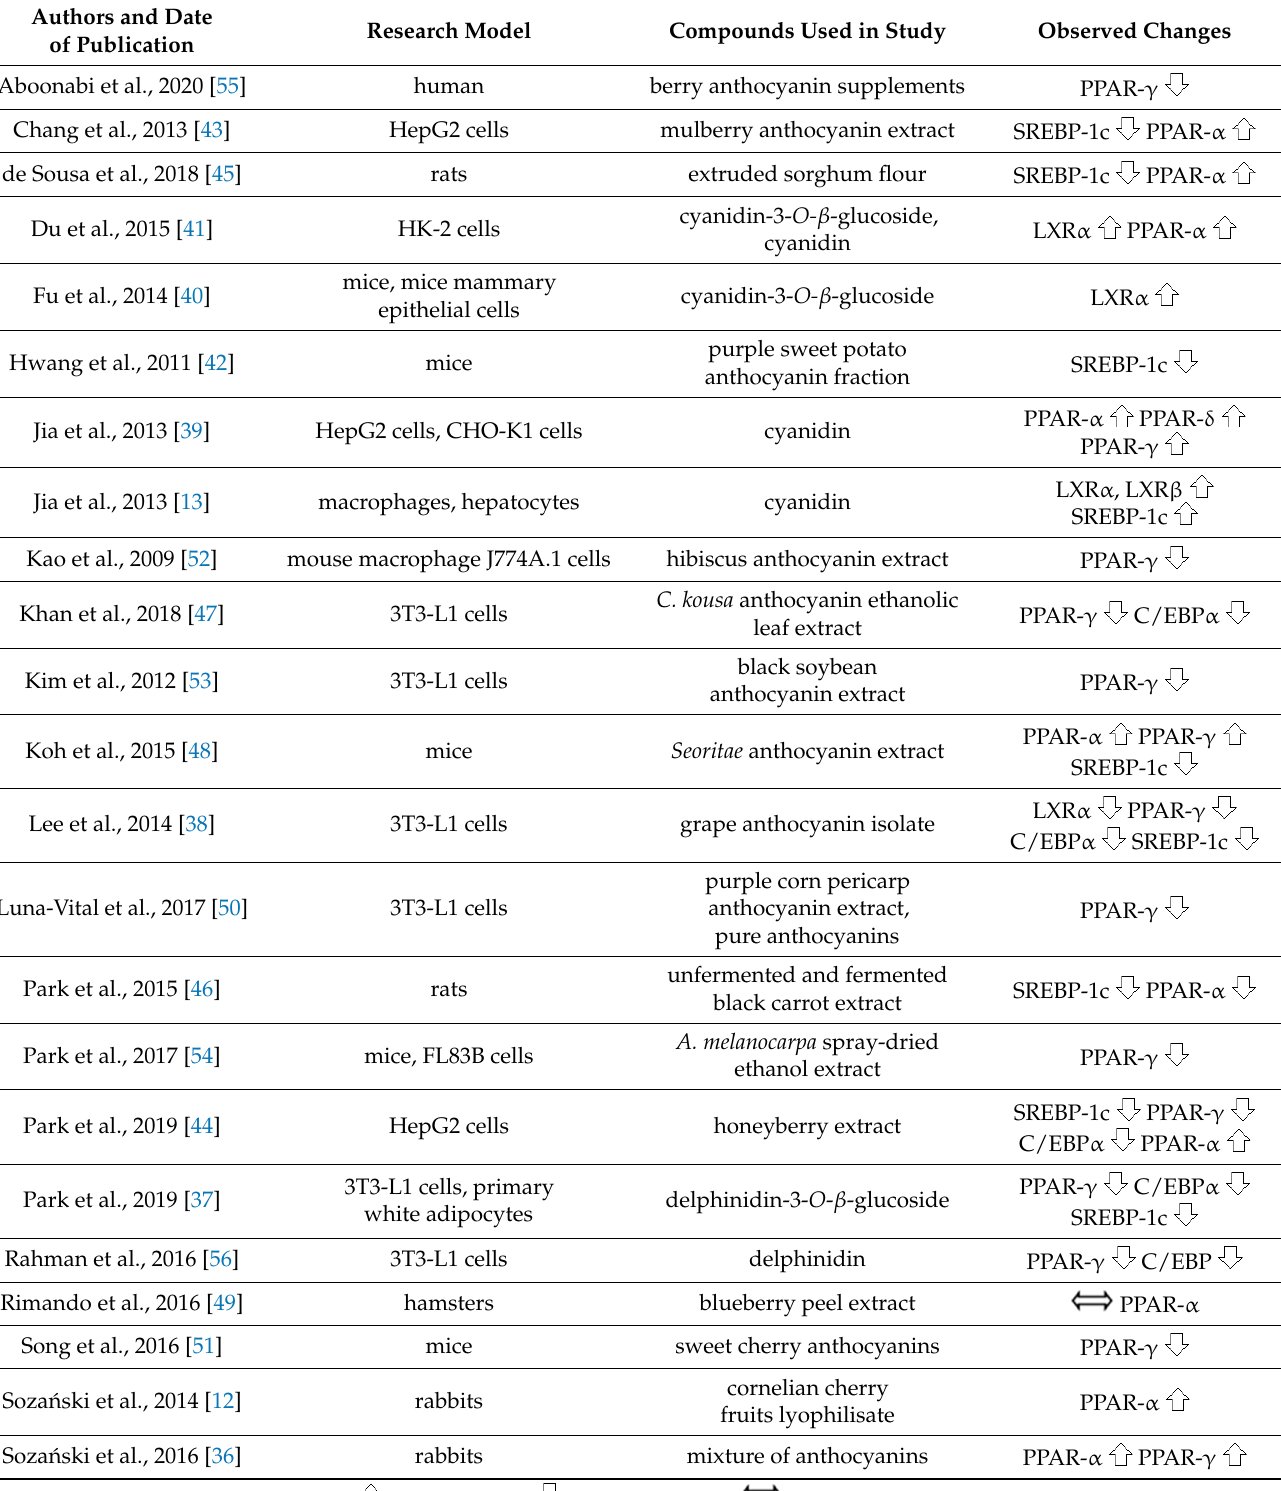
Table 1. List of studies describing the impact of anthocyanins on discussed transcription factors.